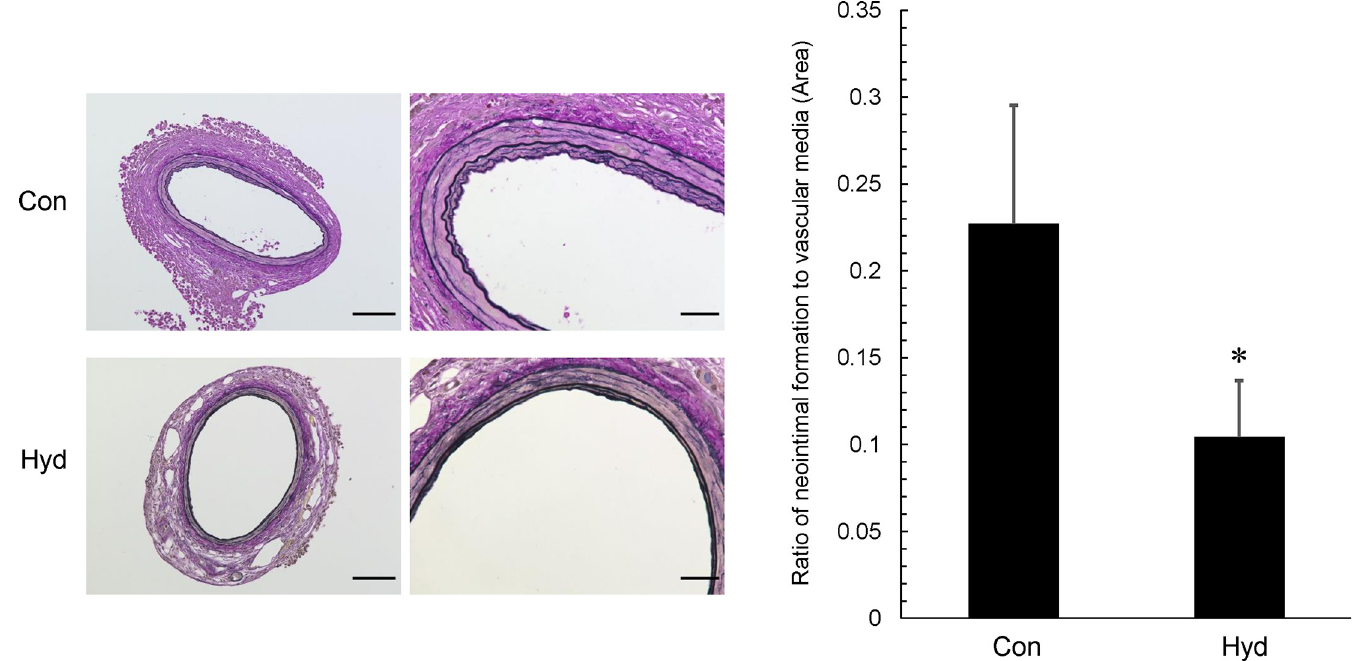
Fig 2. Effect of hydrogen gas inhalation on neointima formation in injured femoral artery after cuff placement. After inhalation of hydrogen gas for 2 weeks from 8 weeks of age in C57BL/6 mice, cuff injury was induced by polyethylene cuff placement around the femoral artery. Representative photos and quantitative analysis of neointimal area in cross sections of femoral artery with elastic van Gieson (EVG) staining are shown. Original magnification × 200 (scale bar: 100 μ m) and × 600 (scale bar: 30 μ m). In quantitative analysis, data represent the ratio of neointima formation area to vascular media area, and values are mean ± SEM (n = 16 for control group (Con), n = 24 for hydrogen group (Hyd)). � p < 0.05 vs.